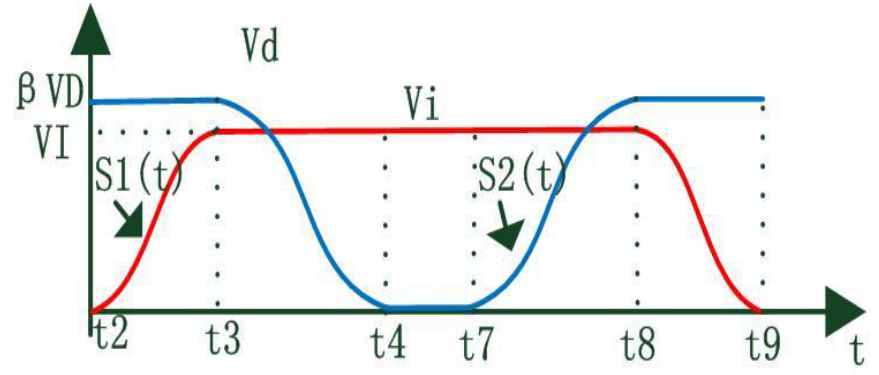
Figure 6. Time domain diagram of Gaussian control signals for voltage and current.